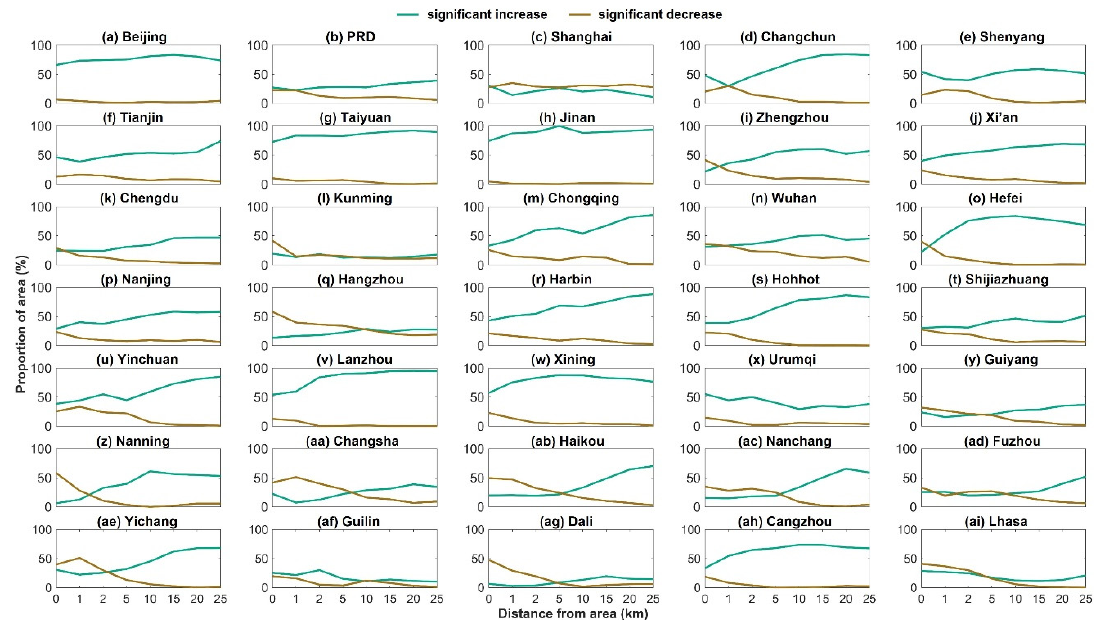
Figure 6. Pixel percentage of vegetation changes in significant increase and significant decrease across 35 cities from 2000–2020. Megacities ( a – c ), megapolis ( d – q ), big cities ( r – ad ), mid-sized cities ( ae , af ), and small cities ( ag – ai ).